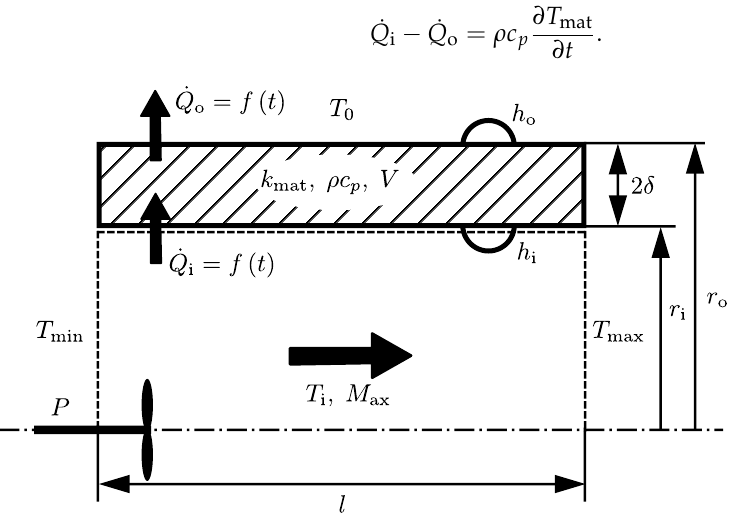
Figure 1. Model of generalized